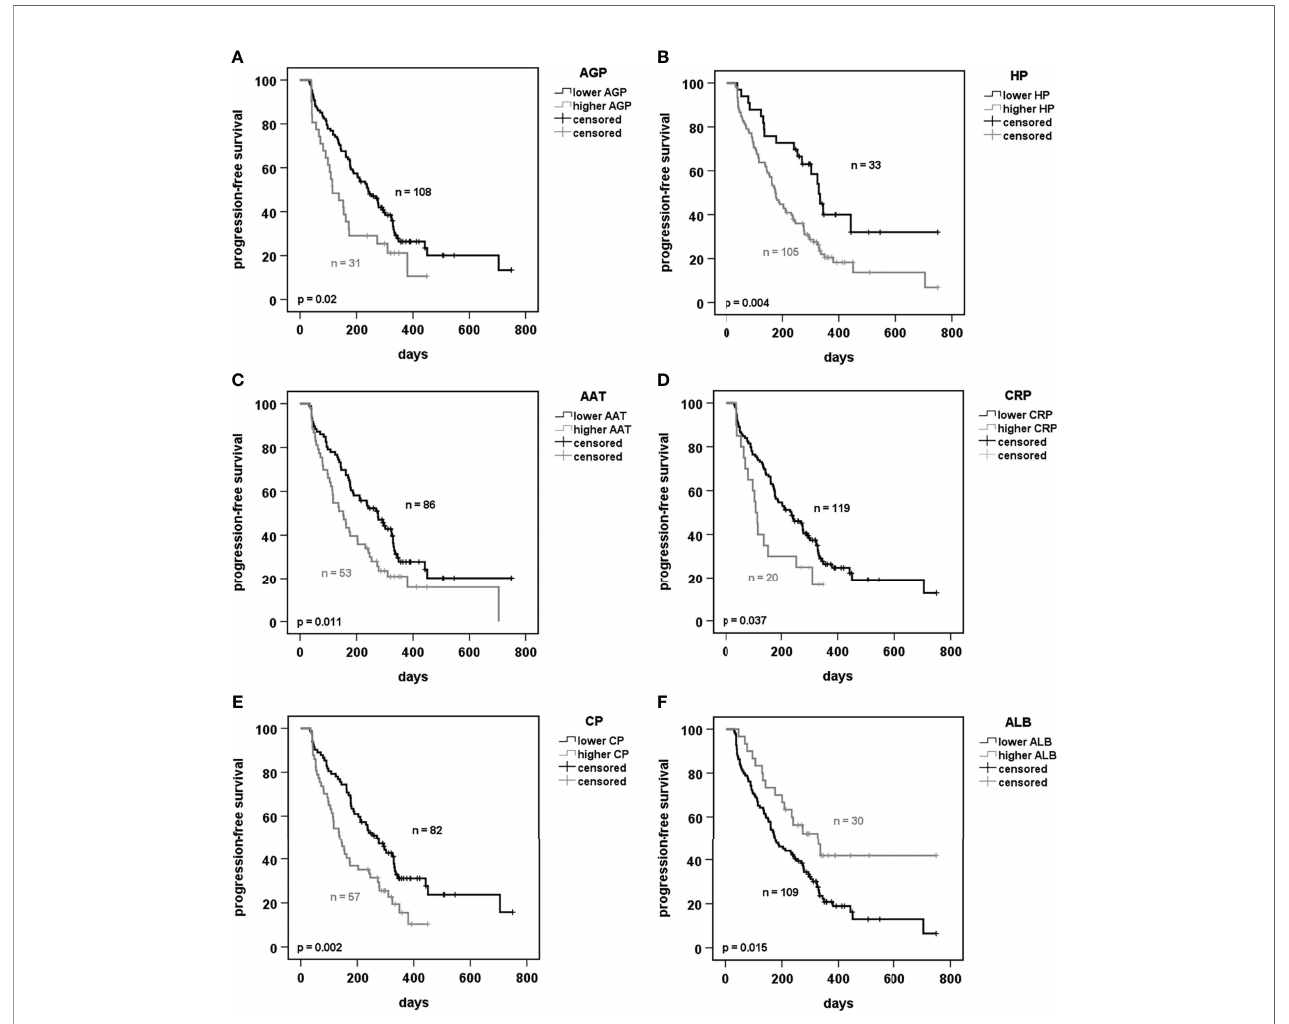
FIGURE 2 | Prediction of progression-free survival of patients receiving PD-1 or PD-L1 immunotherapy dependent on acute phase proteins. (A – F) Kaplan-Meier curves of progression-free survival under immunotherapy in prediction to baseline serum concentrations of the indicated acute phase proteins. Cut-offs were calculated using the software tool “ cutoff- fi nder ” (25). p < 0.05 was considered as signi fi cant. AGP, alpha-1 acid glycoprotein; HP, haptoglobin; AAT, alpha1-antitrypsin; CRP, C-reactive protein; CP, ceruloplasmin; ALB,